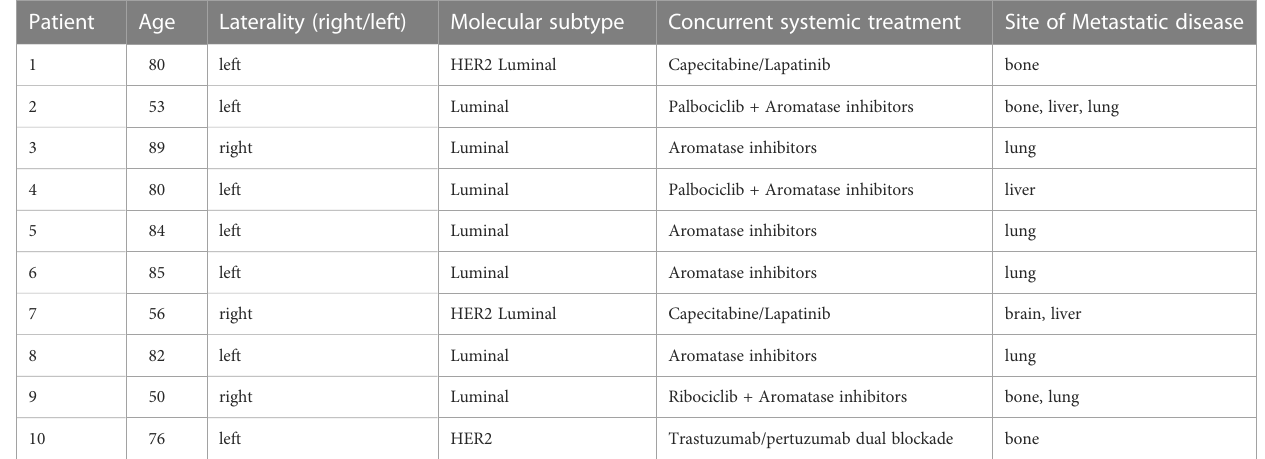
TABLE 1 Patients ’ clinical